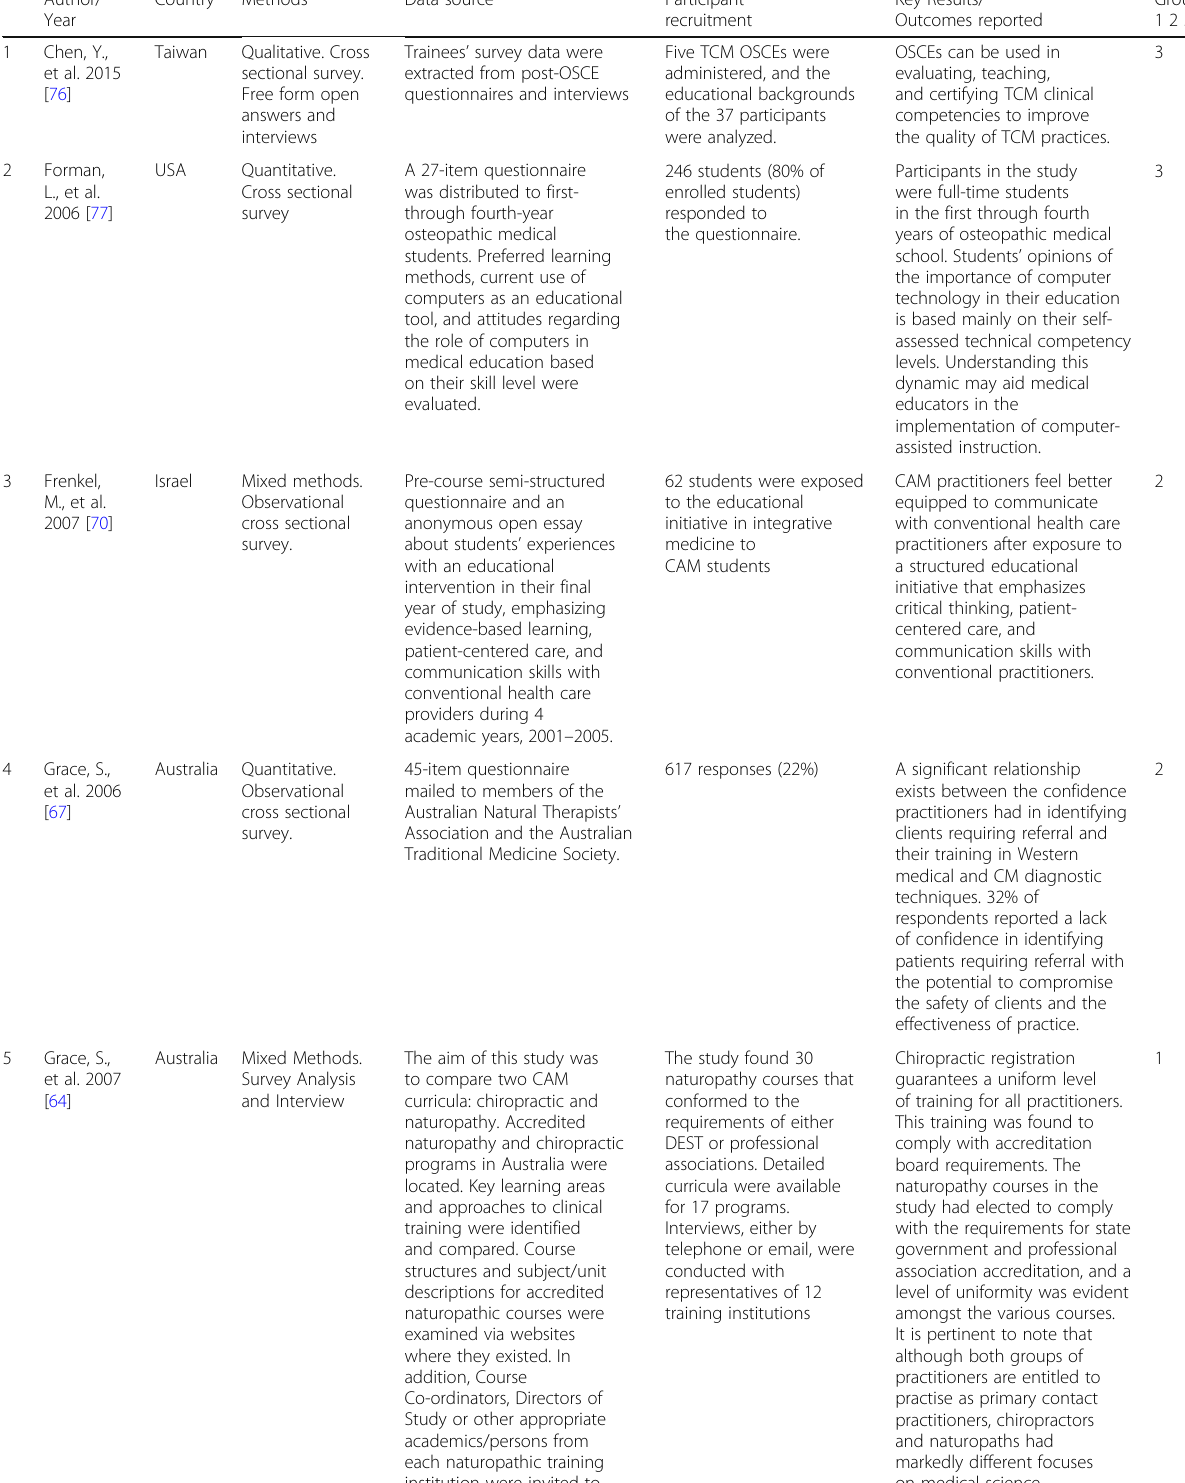
Table 2 Study Characteristics of Included Studies and Thematic Categories (1 CM education provision, 2 The development of educational competencies to develop clinical skills and standards, 3 Application of new educational theory, methods and technology in CM, 3 Future Challenges facing CM